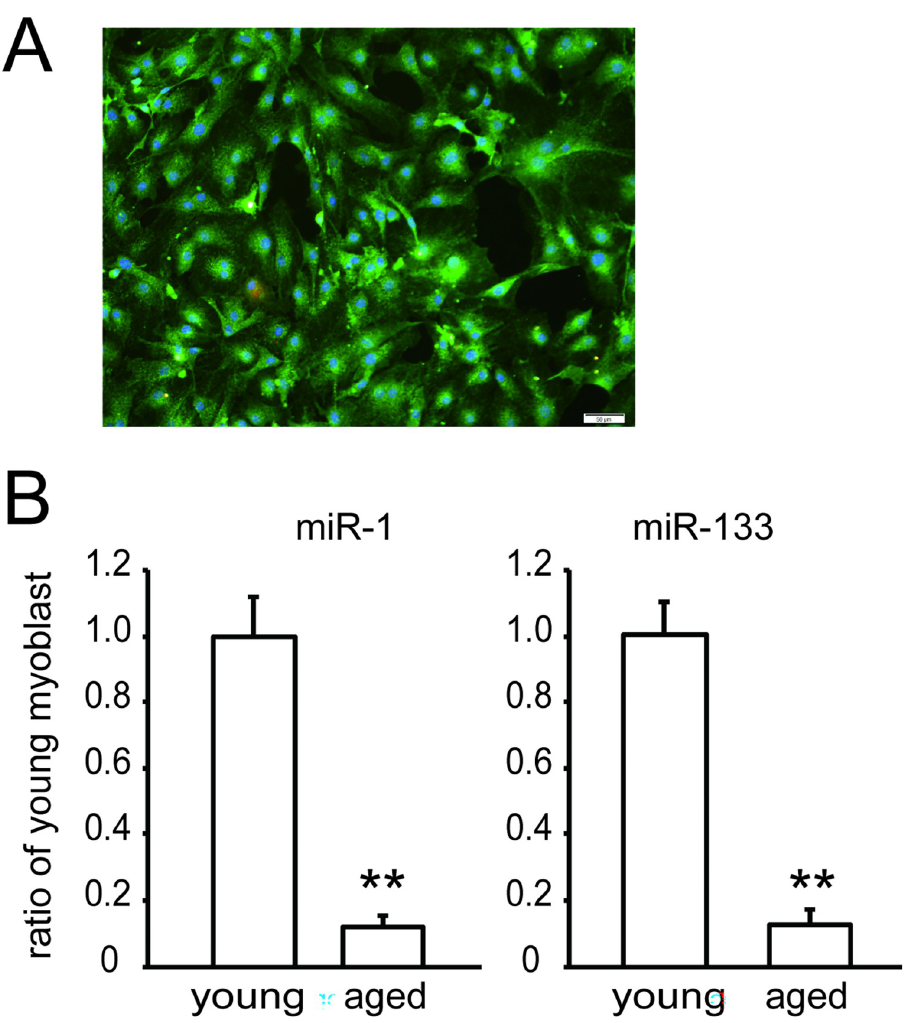
Fig 7. Comparison of miRNA levels in isolated myoblasts between young and aged mice. Panel A shows a representative immunocytochemical image of the isolated myoblast fraction. Green fluorescence of Pax 7, red fluorescence of myosin heavy chain (MHC), and blue fluorescence of nuclei images were merged. Panel B shows miR- 1 and miR-133a levels in myoblasts isolated from young and aged mice. Data are presented as means ± SE (n = 4). �� P < 0.01